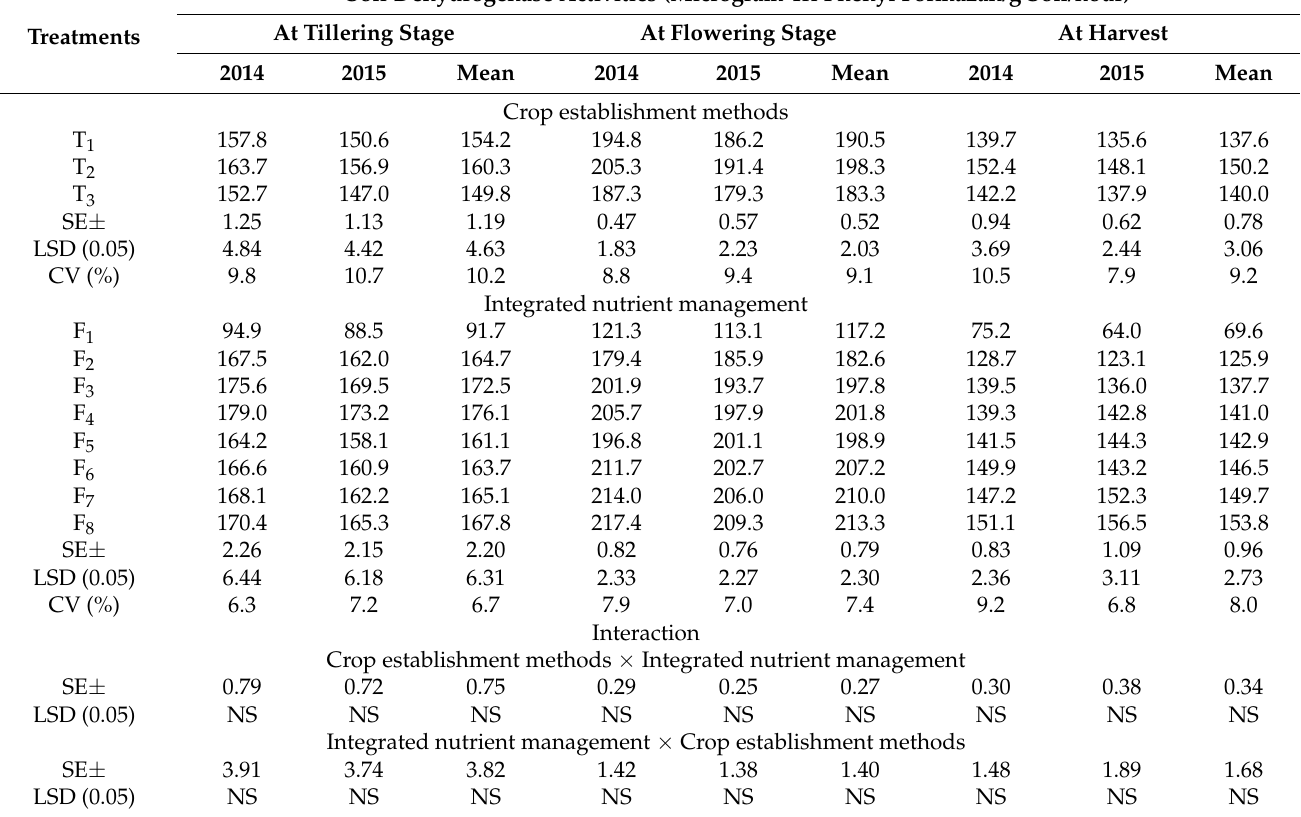
Table 7. Crop establishment methods and integrated nutrient management influence the soil dehydrogenase activities at different growth stages of rice.